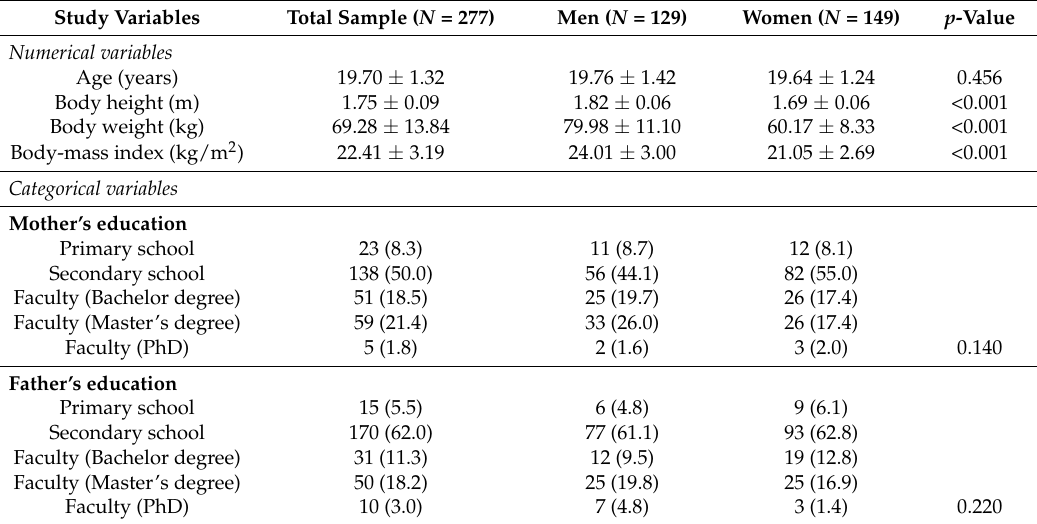
Table 1. Basic descriptive statistics of the study participants expressed as the mean ( ± standard deviation) or number